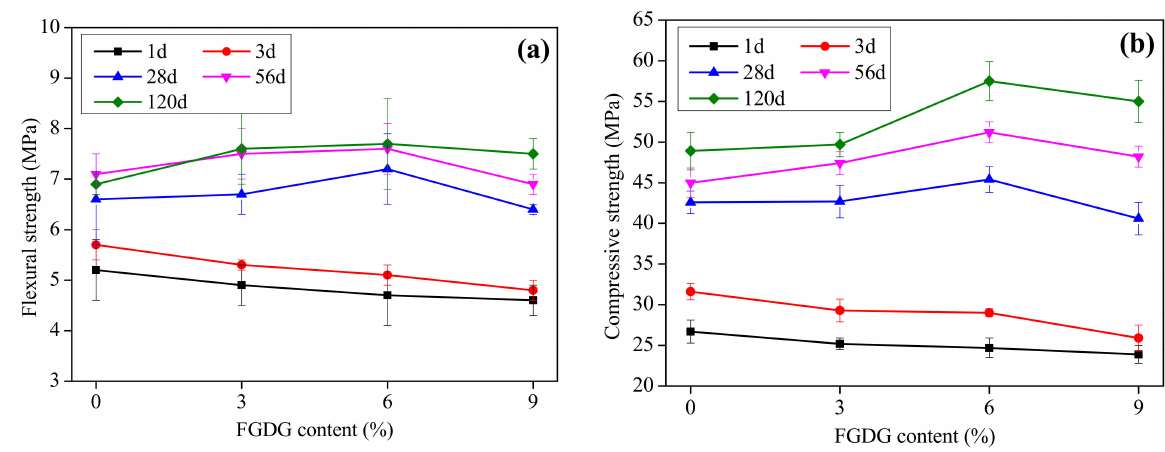
Figure 4. Effect of FGDG content on the mechanical strength of mortar. ( a ) Flexural strength, ( b ) compressive strength.